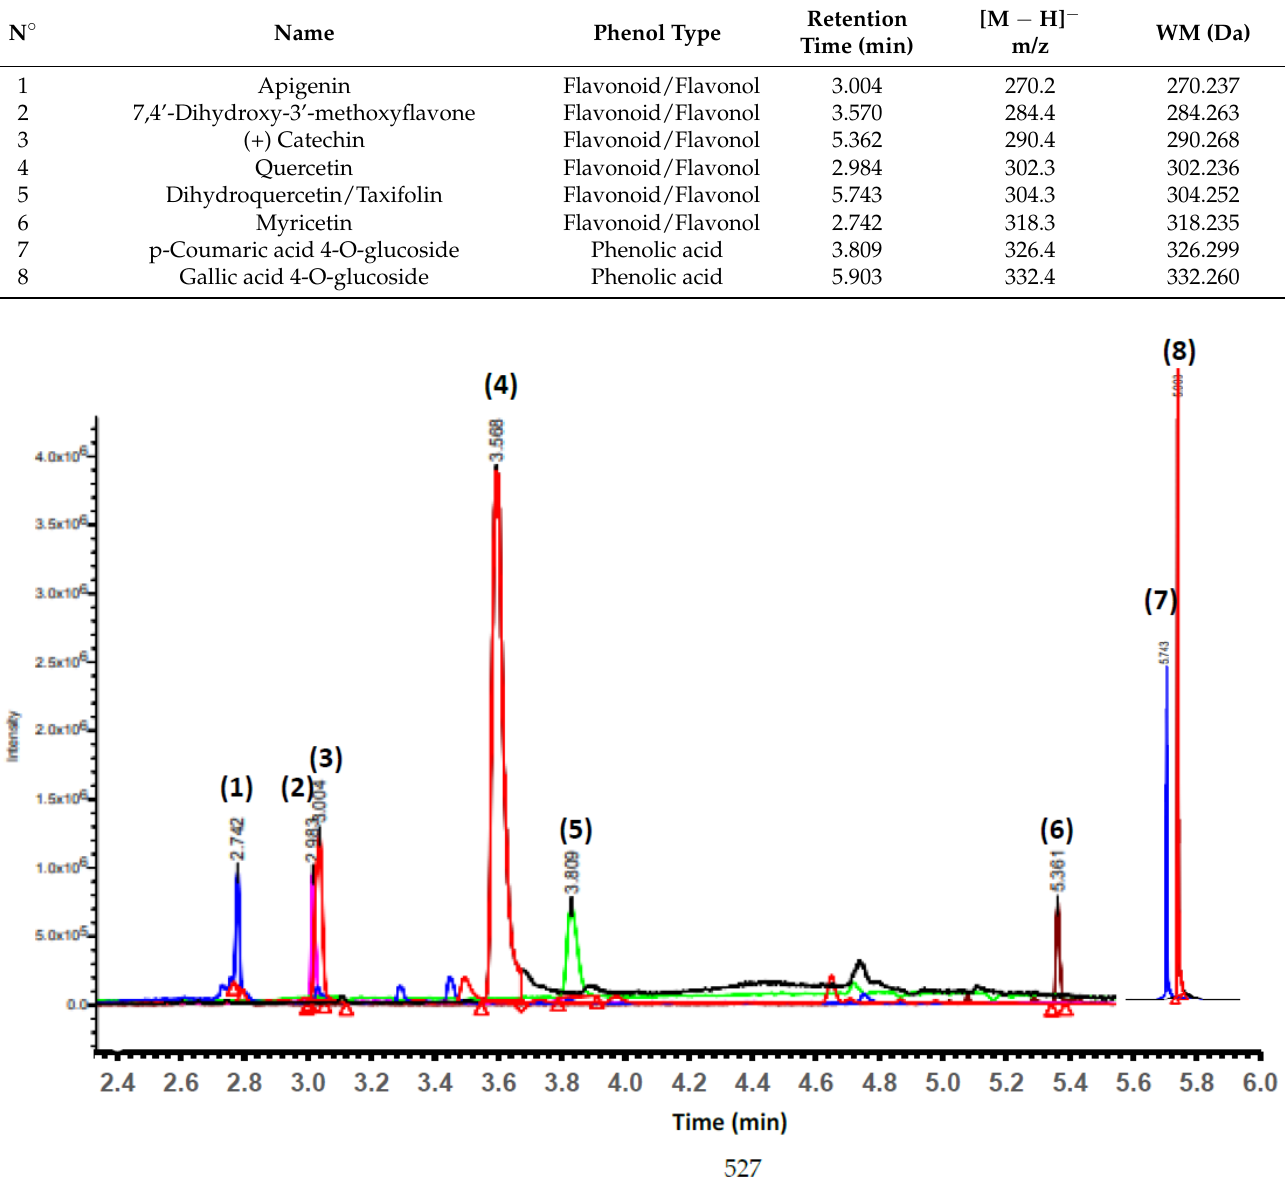
Figure 2. Profile of phenolic components of PCPC35 by UPLC-QDa. (1) Apigenin; (2) 7,4 ’ -Dihy- droxy-3 ’ -methoxyflavone; (3) (+) Catechin; (4) Quercetin; (5) Dihydroquercetin/Taxifolin; (6) Myri- cetin; (7) p-Coumaric acid 4-O-glucoside; and (8) Gallic acid